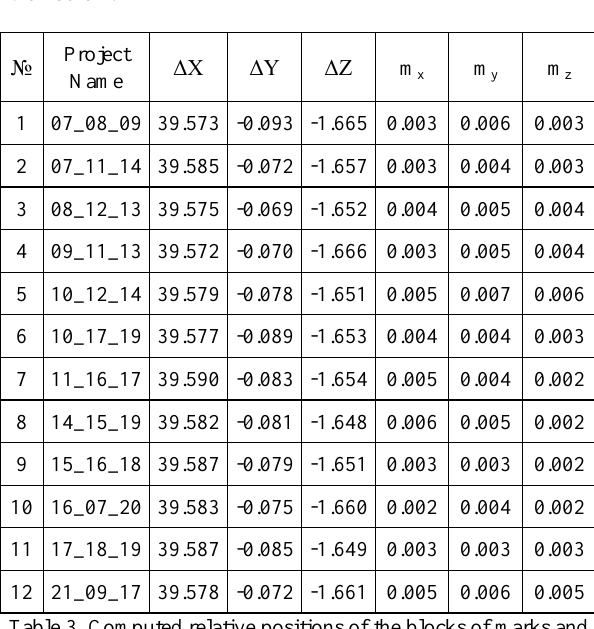
Figure 15. Image No. 11